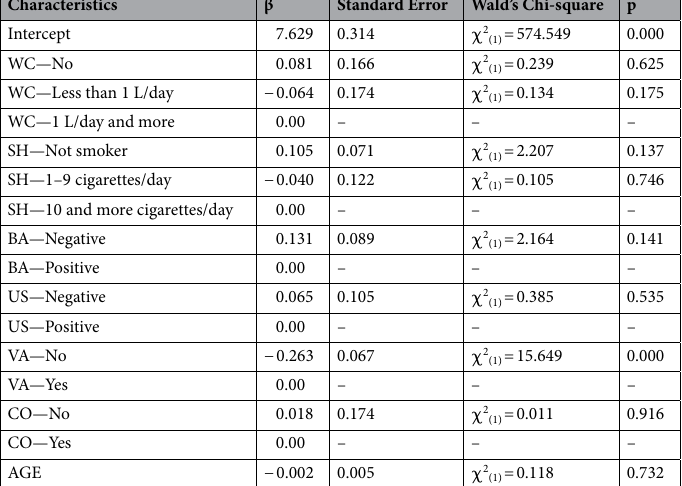
Characteristics β Standard error Wald’s Chi-square